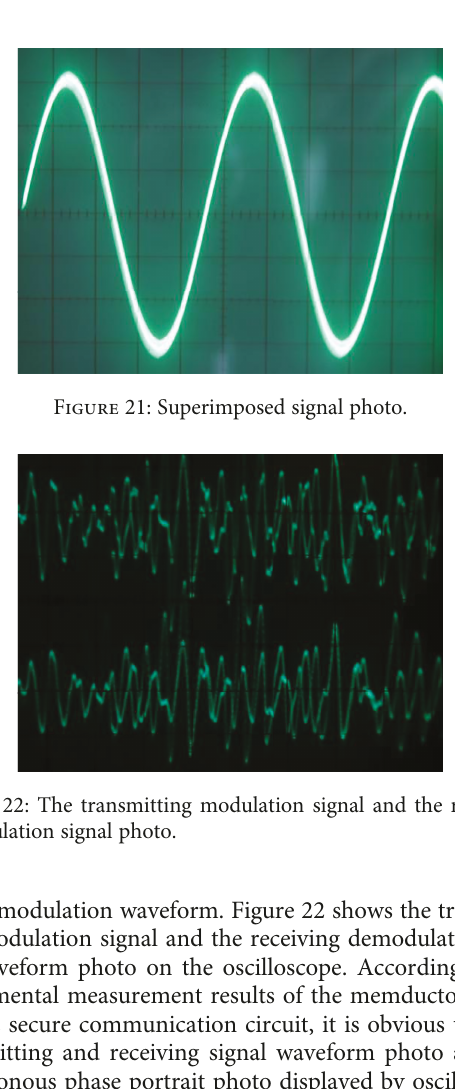
Figure 20: Synchronous phase portrait